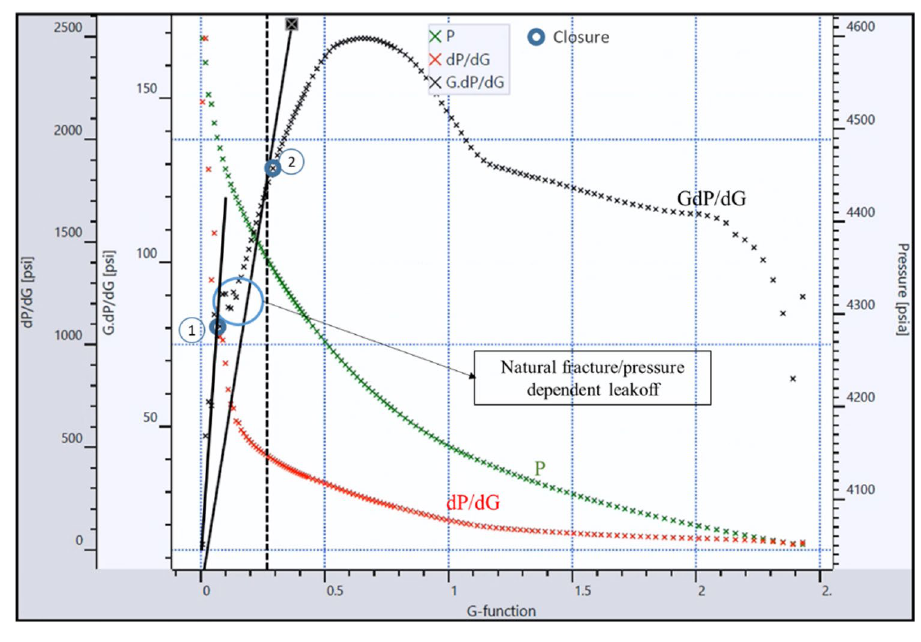
Fig. 15 Log–log diagnostic plot for the DFIT test (Cycle #6). The log–log plot suggests that two closures occurred as the semilog drawdown deriva- tive deviated from ½ slope. Drawdown derivative is (∆ t d∆ P /d∆ t ), and semilog deriva- tive is referring to the Bourdet